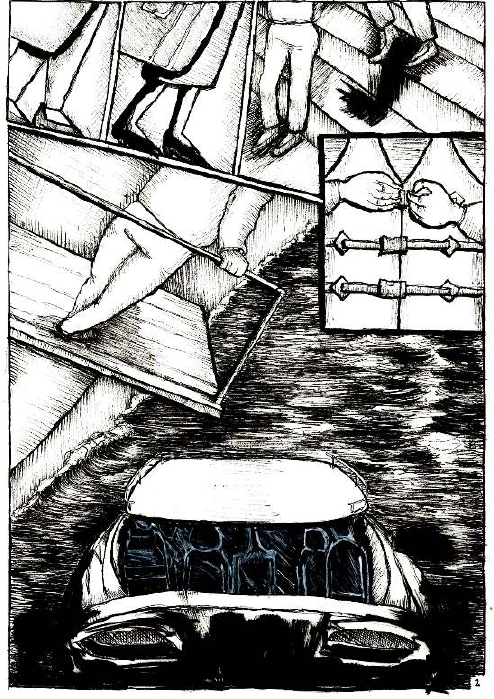
Figure 3: Plate 2, Diamond Princess